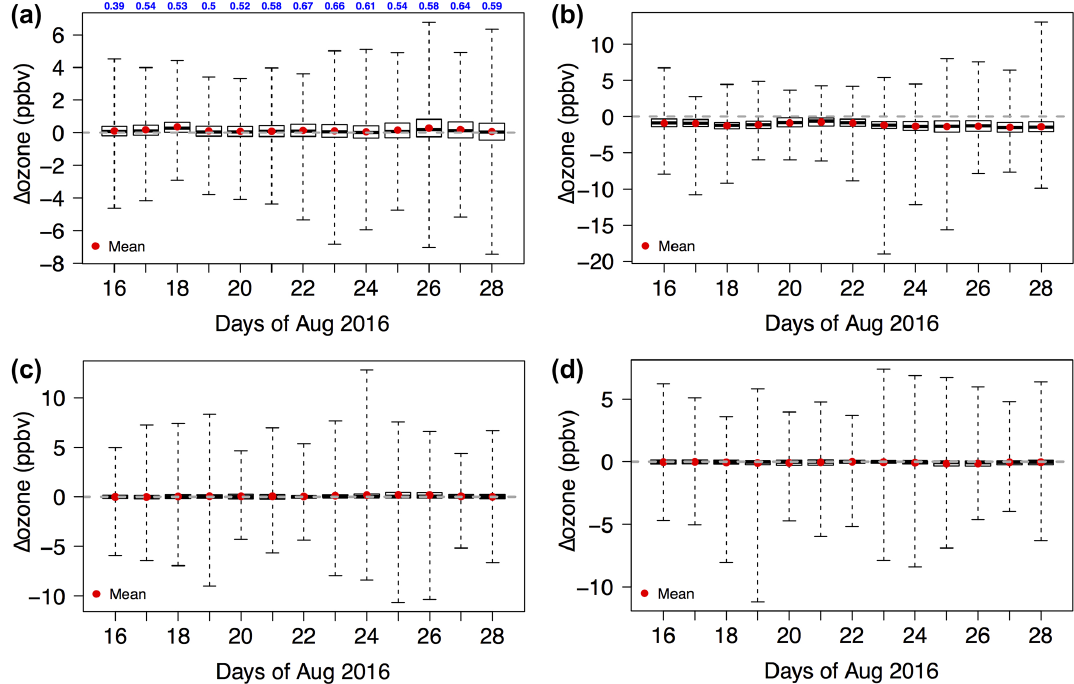
Figure 11. Box-and-whisker plots of WRF-Chem daytime O 3 responses to (a, c) the SMAP DA; and (b, d) updating anthropogenic emissions from NEI 2014 to NEI 2016 beta. Panels (a–b) and panels (c–d) show O 3 changes at the surface (only for terrestrial model grids, 68% of all model grids) and at ∼ 400hPa (in all model grids), respectively. Blue text in (a) shows spatial correlation coefficients r between WRF-Chem daily daytime 2m air temperature changes and O 3 changes due to the SMAP DA. Note the different y -axis